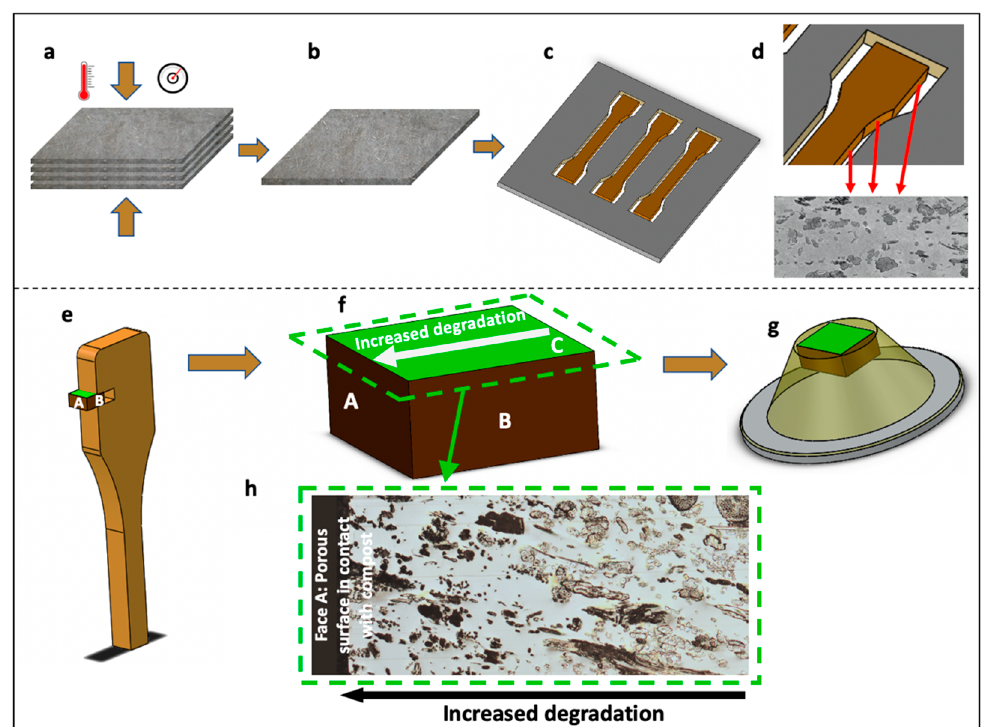
Figure 1. Manufacturing of the composite plates: ( a ) stacking of PLA-flax non-woven layers for hot compression; ( b ) is the obtained composite plate; ( c ) is the plate after the specimen cutting process; and ( d ) focuses on the structure of the edge of the specimen with apparent flax fibre cross-sections after cutting; ( e ) is a schema of the dog-bone sample indicating the region of sampling. The green face C ( f , g ) was specifically investigated in this paper; the extracted sample was embedded in agar low viscosity resin and glued on an AFM sample holder ( g ). Face A represents the most porous ‘exposed’ face ( h ), in contact with the compost, as the dog-bone sample was cut by a milling machine, whereas faces B are less porous external faces in contact with thermo-compression plates, and the green face C was the one investigated by optical, electronic and atomic force microscopy.